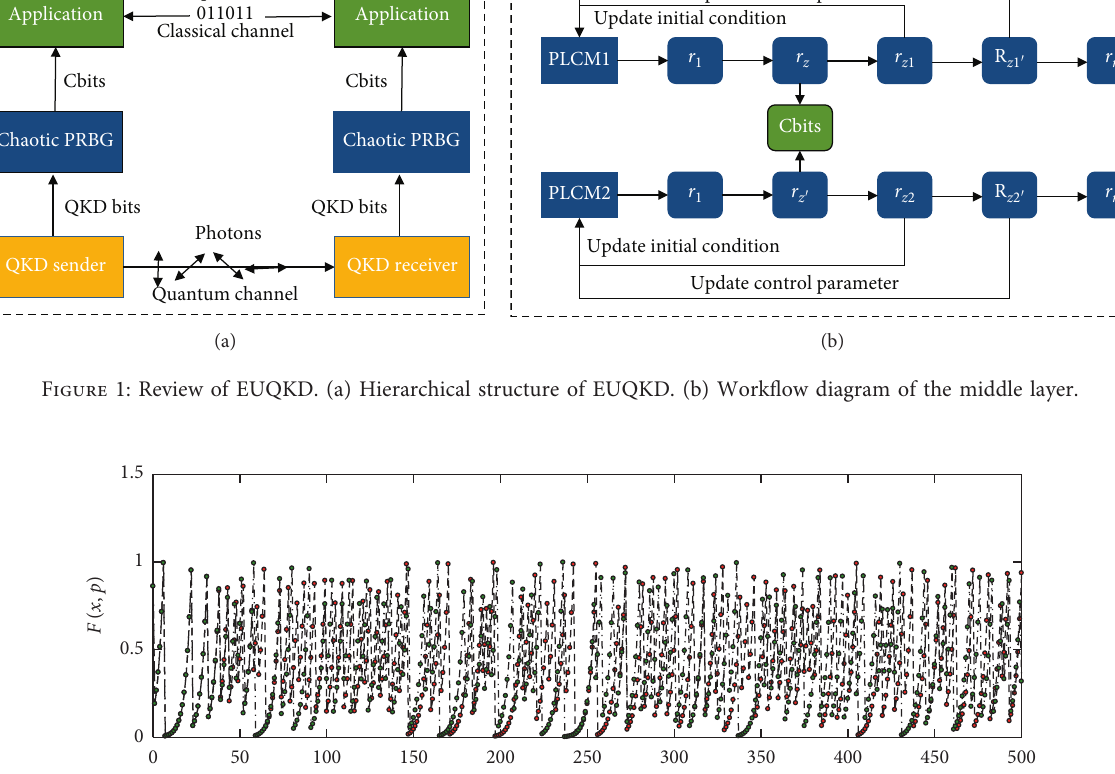
Figure 3. Alice can control four lasers to send horizontal, vertical, + 45 ° , and − 45 ° polarization pulses, which are denoted as H , V , + , and − , respectively. Because the intensity